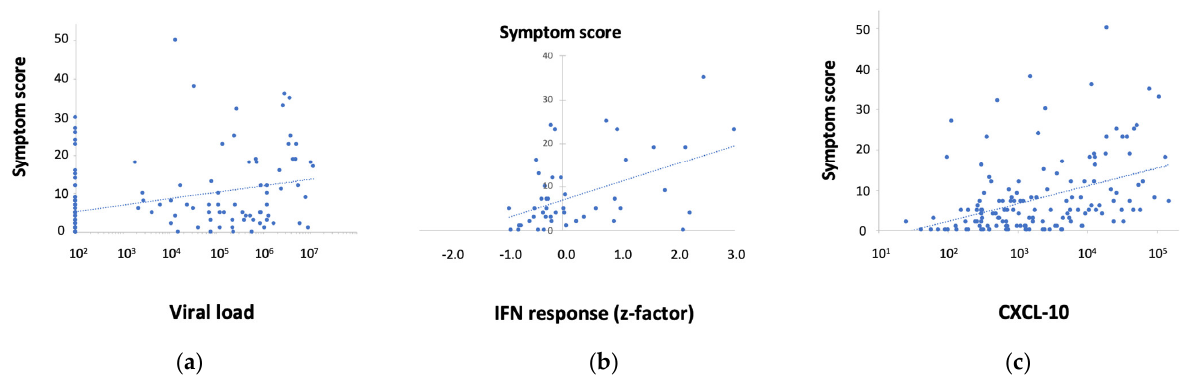
Figure 4. ( a ) Weak association between viral load and WURSS symptom scores on d3 ( p < 0.003), ( b ) Association between IFN-response genes and WURSS symptom scores on d3 ( p < 0.04), ( c ) Associa- tion between CXCL-10 in nasal lavage and WURSS symptom scores on d3 ( p < 0.0001). Statistical analyses were performed using linear regression analysis, showing positive associations.